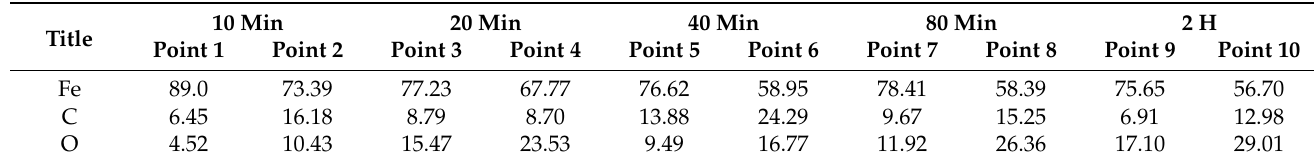
Table 1. The main elements and content in corrosion products at the black-gray area under different corrosion times within 2 h (wt.%).